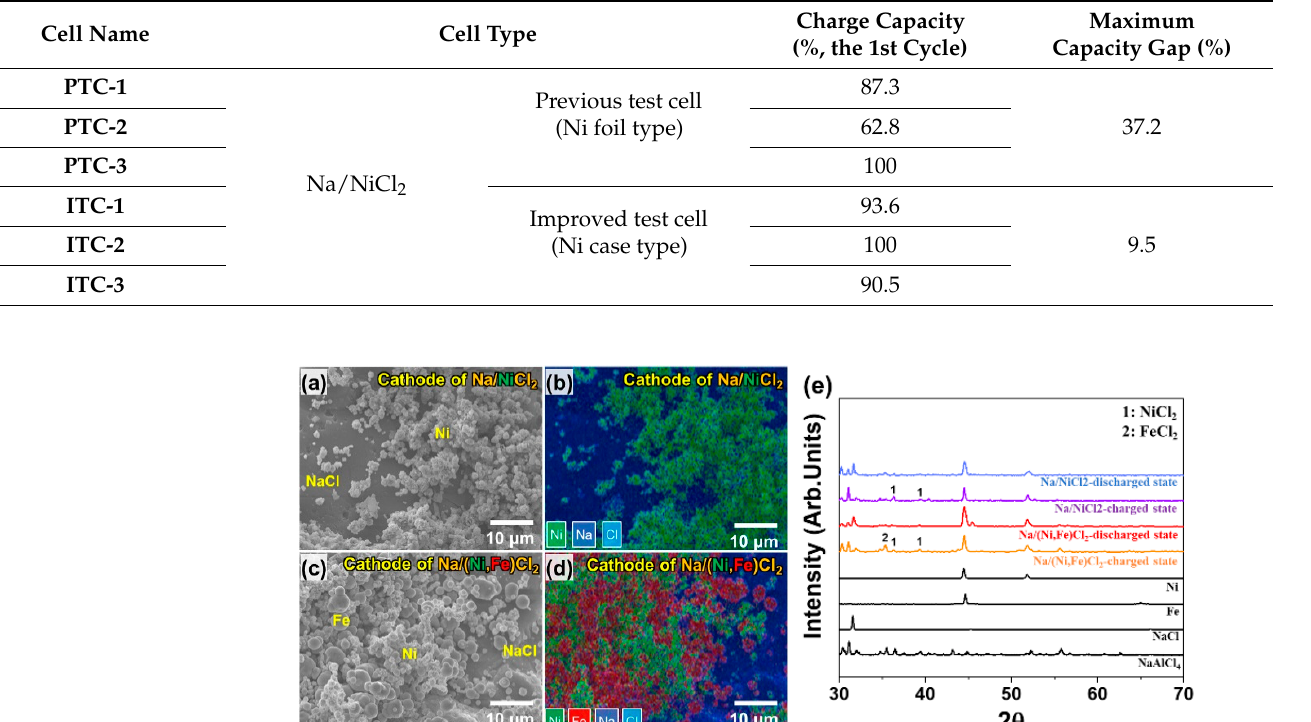
Table 1. Initial charge capacity of previous test cells and improved test cells, and maximum charge capacity gap of each group.